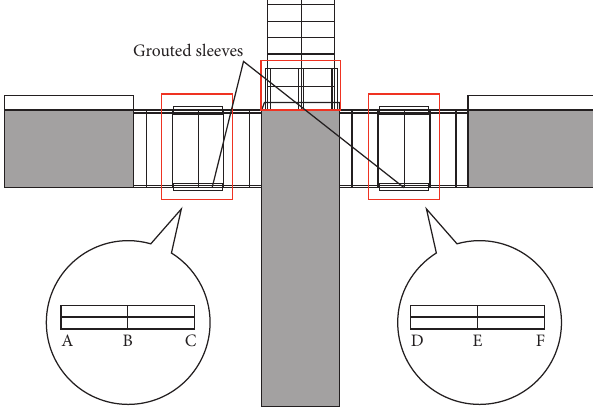
Figure 12: Position of the strain measuring